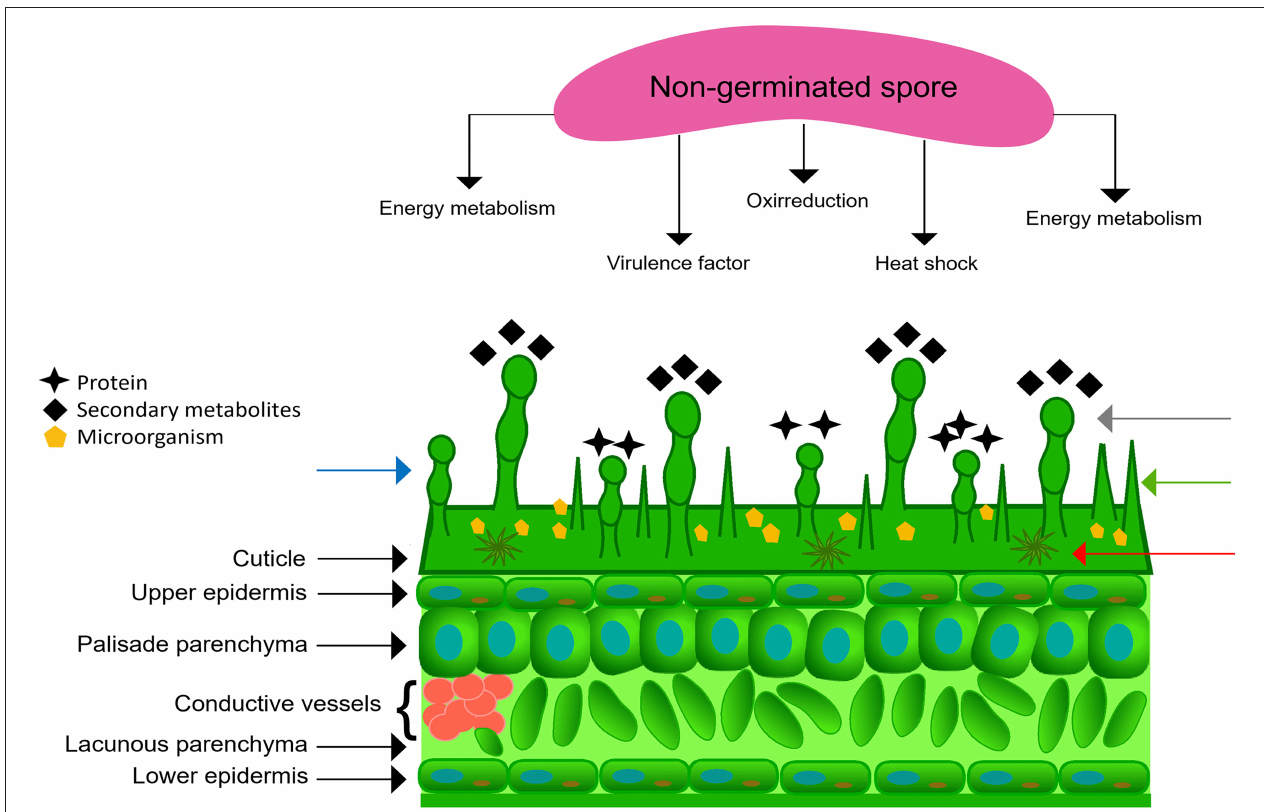
FIGURE 1 | Pre-infection communication of pathogen and the phylloplane. Preformed proteins in a non-germinated spore and leaf cross-section. The arrows indicate simple (green), stellate (red), long glandular (gray), and short glandular (blue) trichomes.